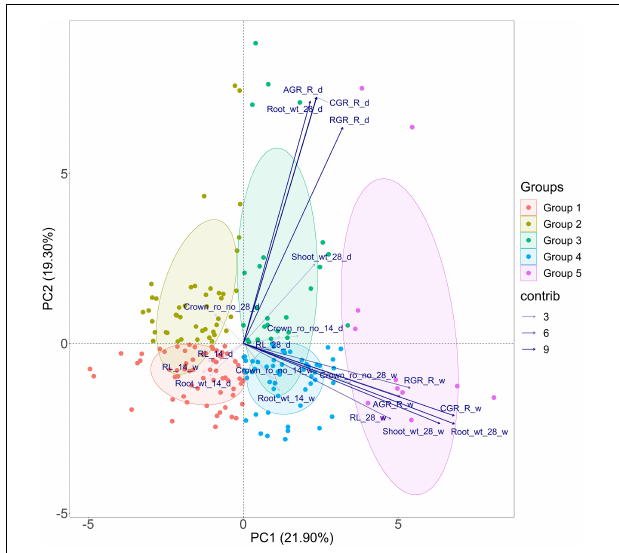
FIGURE 3 | PCA for root length, dry weight, crown root number, and root vigor index of dry (d) and wet (w) season under DSR conditions explained by two axes. Together, the two PC axes explained 41.2% of the total variance. The transparency of the vector indicates the contribution to the variance in the dataset, ranging from 3 (lightest) to 9% (darkest). The direction and length of the vector represent the trait contribution to the first two components of the PCA. Genotypes are grouped into five based on their expression pattern of root traits measured under DSR conditions. Group 1 (solid red tone) and Group 2 (solid algae tone) share poor root vigor parameters, Group 3 (solid green tone) performed well during the dry season, Group 4 (solid cyan tone), and Group 5 (solid purple tone) share high values for root vigor traits during the dry season at 28 days and wet